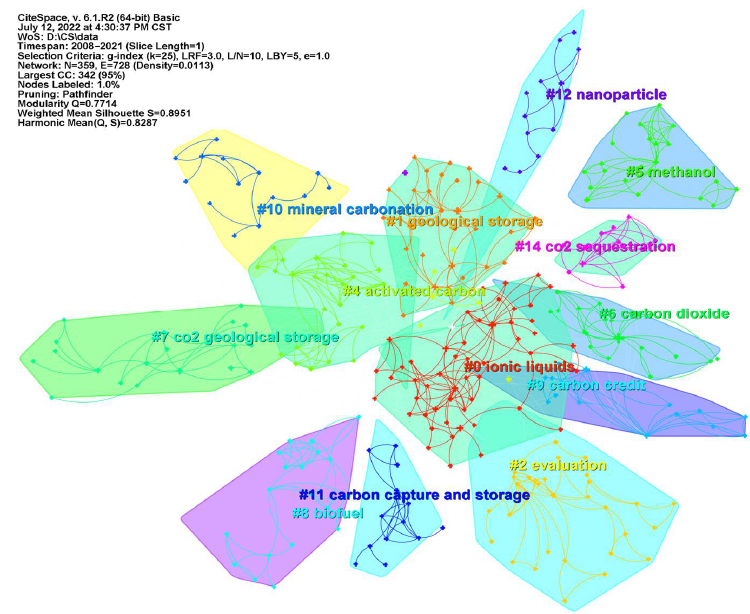
Figure 23. Keyword clustering map.